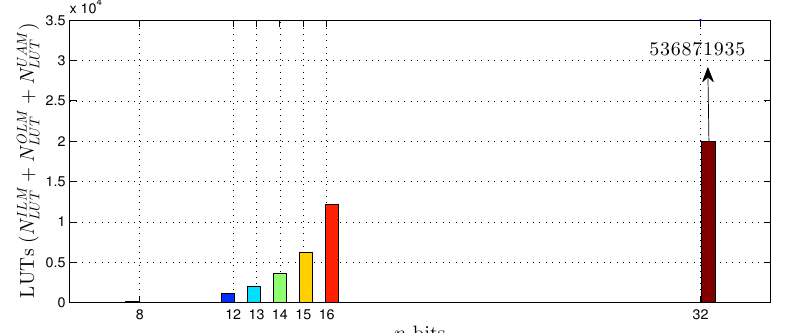
Figure 11. Area occupied (LUTs) for different fixed point formats, in the XOR gate